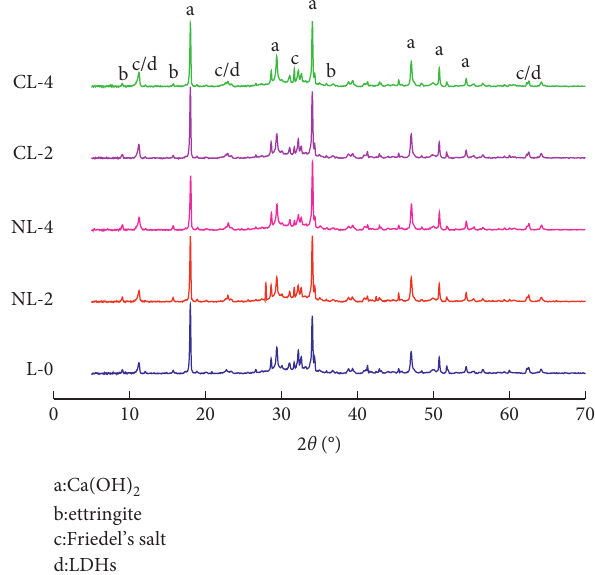
Figure 4: XRD pattern of concrete powder with LDHs at a distance of 9 ∼ 11mm from the exposed surface of